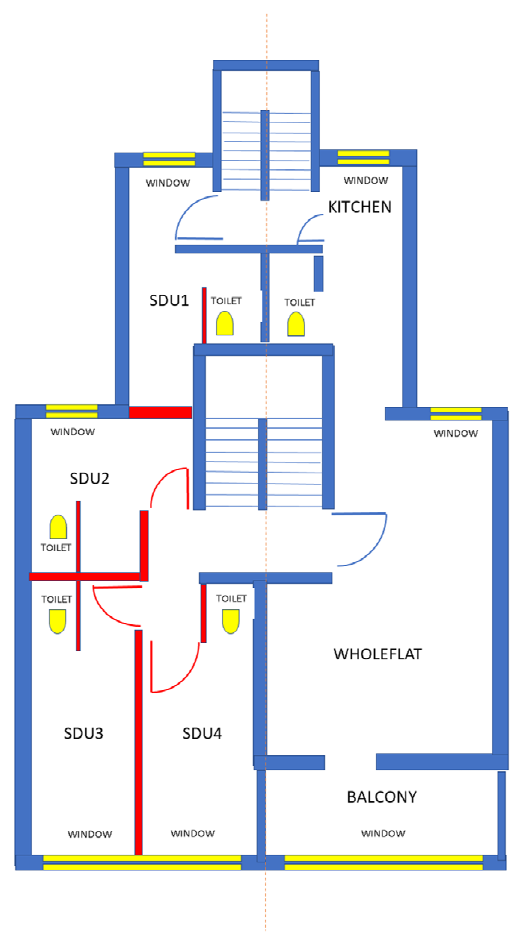
Figure 1. A floor plan of a typical flat and its mirror image flat being subdivided into four SDUs. Notes: The figure shows one whole flat without subdivision (the unit on the right-hand side) and a mirror image of the flat being subdivided into four SDUs, viz. SDU1, SDU2, SDU3, and SDU4 (the unit on the left-hand side). It shows that the living room is subdivided into three SDUs, and the original kitchen and toilet are converted into another SDU. In this typical case, all the SDUs have independent toilets and windows as shown, but in some cases the subdivisions may not be able to provide an independent toilet and/or a window for each SDU. The associated building works in the subdivision can result in various irregularities posing building safety problems. Source: drawn by the authors.